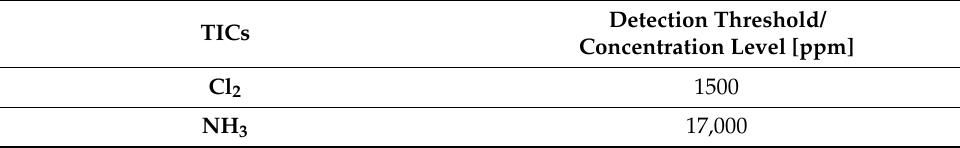
Table 2. Detection threshold of chemicals from the TIC